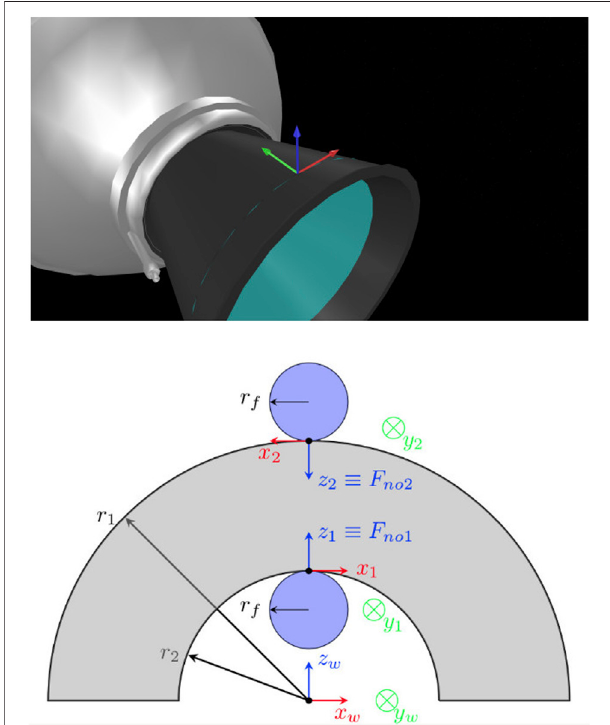
FIGURE 2 | Top: a grasping pose on the bell surface, indicated with a coordinate frame. The green and red arrows show the direction of minimum and maximum curvatures ( y -axis and x -axis). Bottom: frontal view of the AKM nozzle bell and robotic fi ngers, as would be seen by the robot ’ s camera. The coordinate frames on the fi ngertips are the frames O A 1 and O A 2 . The respective O B framesaretheprincipalcurvatureframeson thenozzlesurface. For visualisation, we note the internal and external radii of the nozzle with r 2 and r 1 , but for a real nozzle we have r 1 ≈ r 2 . The normal force applied from each fi ngertip is F n 1 and F n 2 . The grasp is in equilibrium if F n 1 (cid:1) F n 2